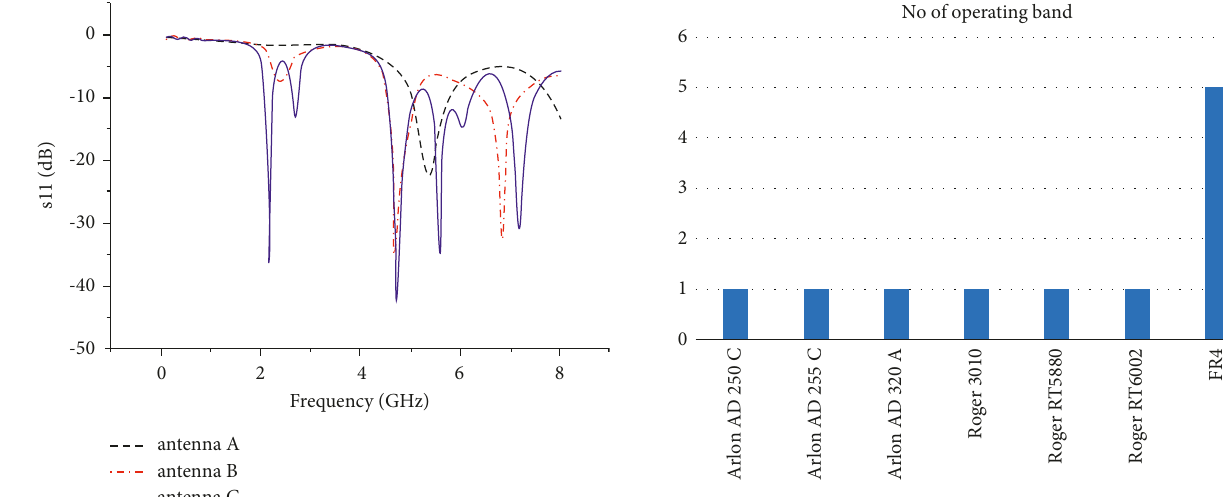
Figure 5: Number of operating bands for various